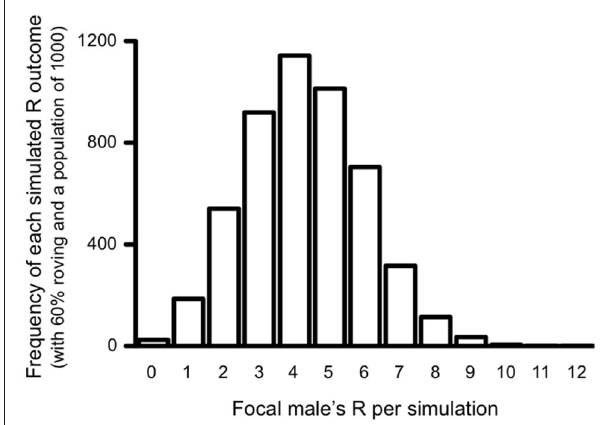
FIGURE 2 | Histogram of total reproductive success (R) outcomes for the simulated roving focal male after 5000 simulations. The histogram represents the simulation results for which 60% of the males in the population roved, and the pair population was 1,000.